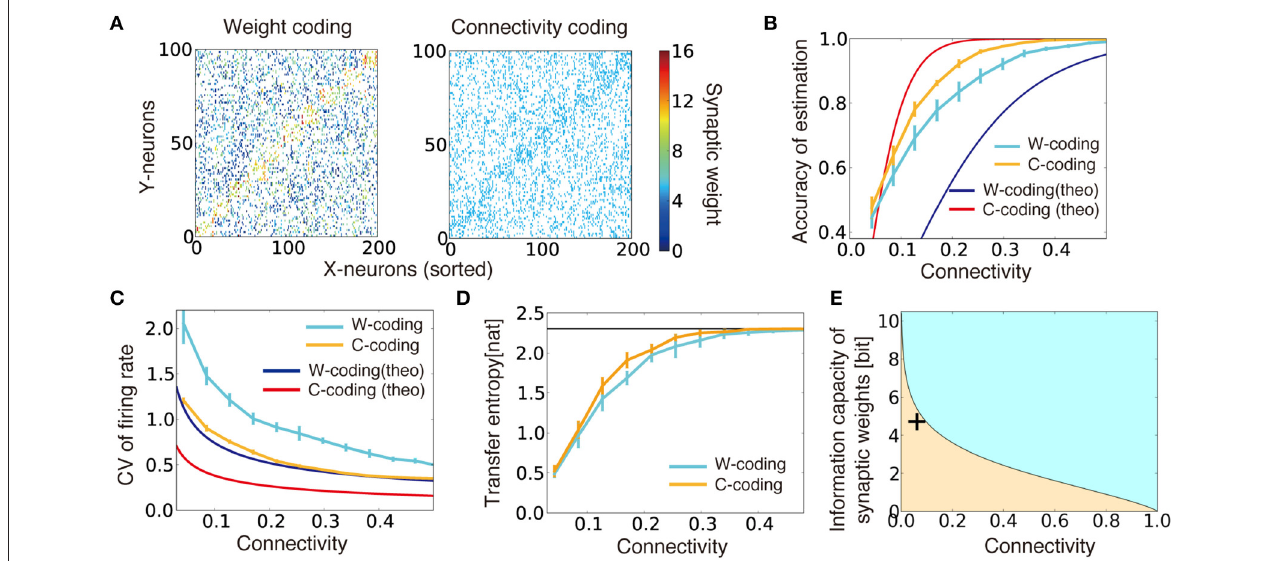
FIGURE 2 | Performance comparison between connectivity coding and weight coding. (A) Examples of synaptic weight matrices in weight coding (W-coding) and connectivity coding (C-coding) schemes calculated at γ 0.2. X-neurons were sorted by their selectivity for external states, and colors represent synaptic = weights. (B) Comparison of the performance between connectivity coding and weight coding schemes at various sparseness of connectivity. Orange and cyan lines are simulation results. The error bars represent standard deviation over 10 independent simulations. In the following panels, error bars are trial variability over 10 simulations. Red and blue lines are analytical results. (C) Analytically evaluated coefficient of variation (CV) of output firing rate and corresponding simulation results. For simulation results, the variance was evaluated over whole output neurons from their firing rates for their selective external states. (D) Estimated maximum transfer entropy for two coding strategies. Black horizontal line is the maximal information log e p . (E) Relative information capacity of connection structure vs. synaptic weight is shown at various values of synaptic connectivity. In the orange (cyan) area, the synaptic connectivity has higher (lower) information capacity than the synaptic weights. Plus symbol represents the data point obtained from CA3-to-CA1